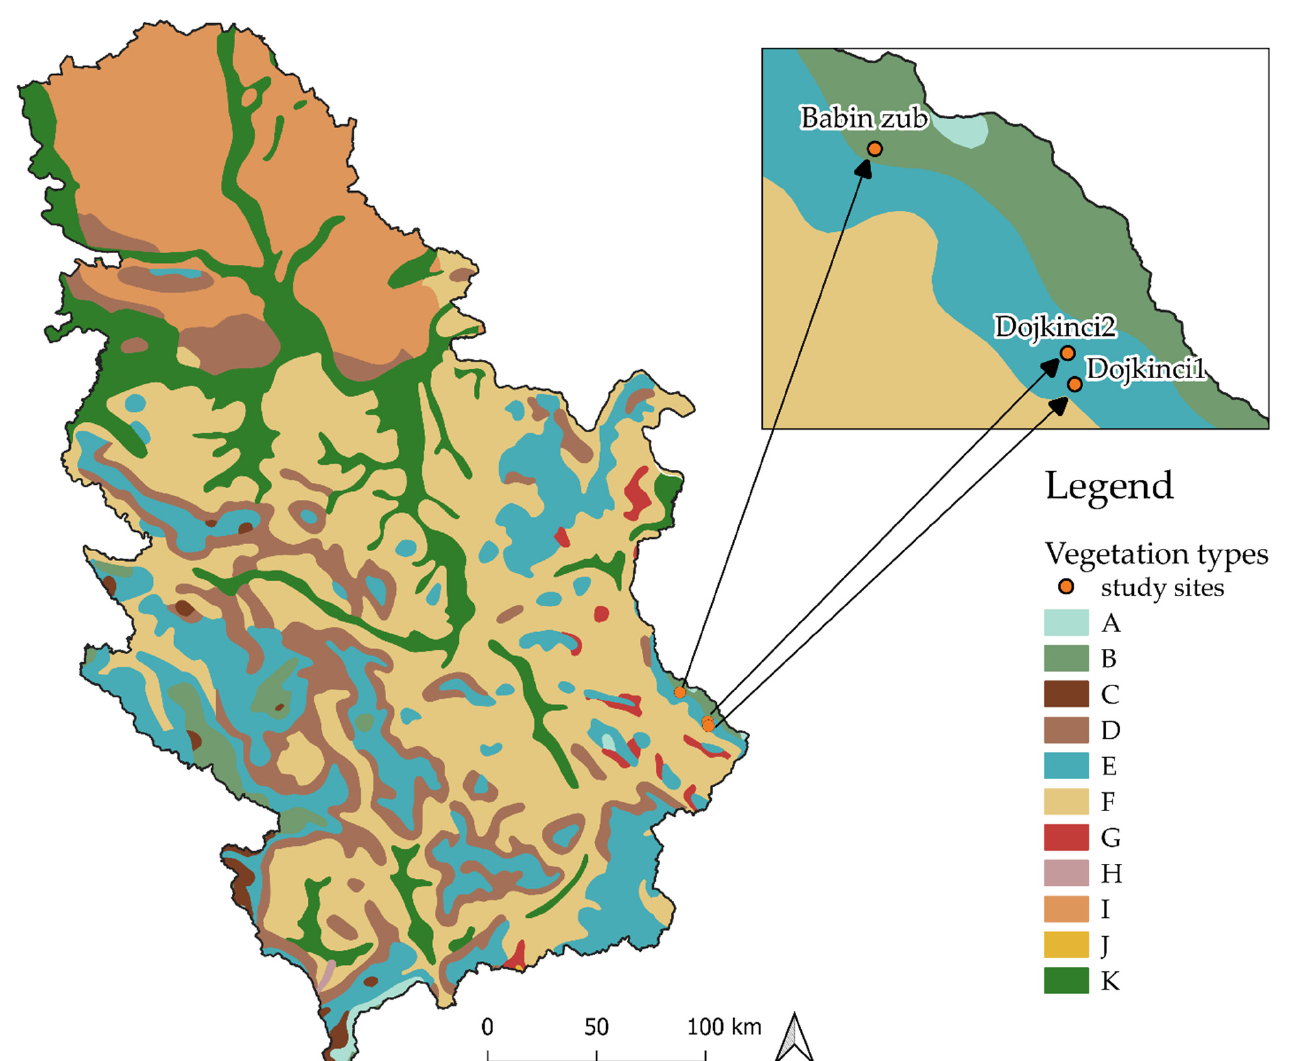
Figure 3. Vegetation types in Serbia from the EPNV map: A, Alpine; subalpine and oro-Mediterranean vegetation; B, montane spruce and mixed spruce forests; C, montane pine forests; D, acidophilous oak and mixed oak-hornbeam forests; E, beech and mixed beech forests; F, thermophilous mixed bitter, pedunculate, or sessile oak forests; G, south-east Balkan sub-Mediterranean mixed oak forests; H, south-west Balkan sub Mediterranean mixed oak forests; I, Pannonian lowland mixed oak forests and steppes; J, Mediterranean mixed forests; K, hardwood alluvial forests, wet lowland forests, and swamps.